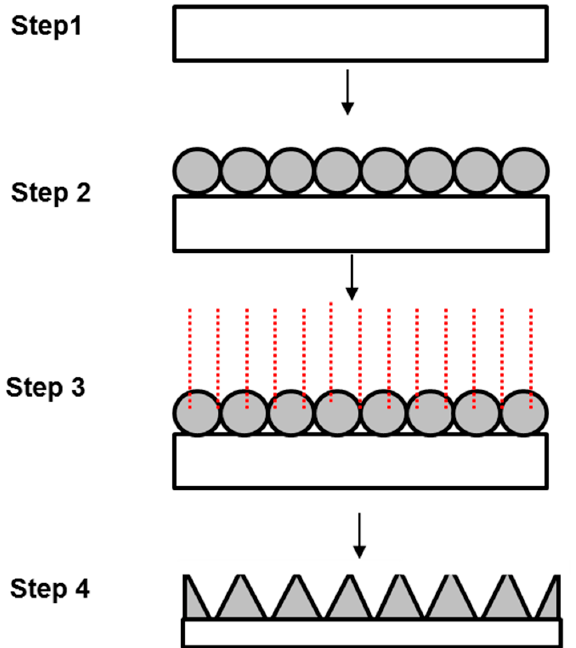
Figure 2. Schematic of the colloidal/nanosphere lithographic process. Step (1) preparation of biopolymer substrate; Step (2) nanosphere masking of substrate; Step (3) Reactive ion etching of masked substrate; and Step (4) completed NSS.